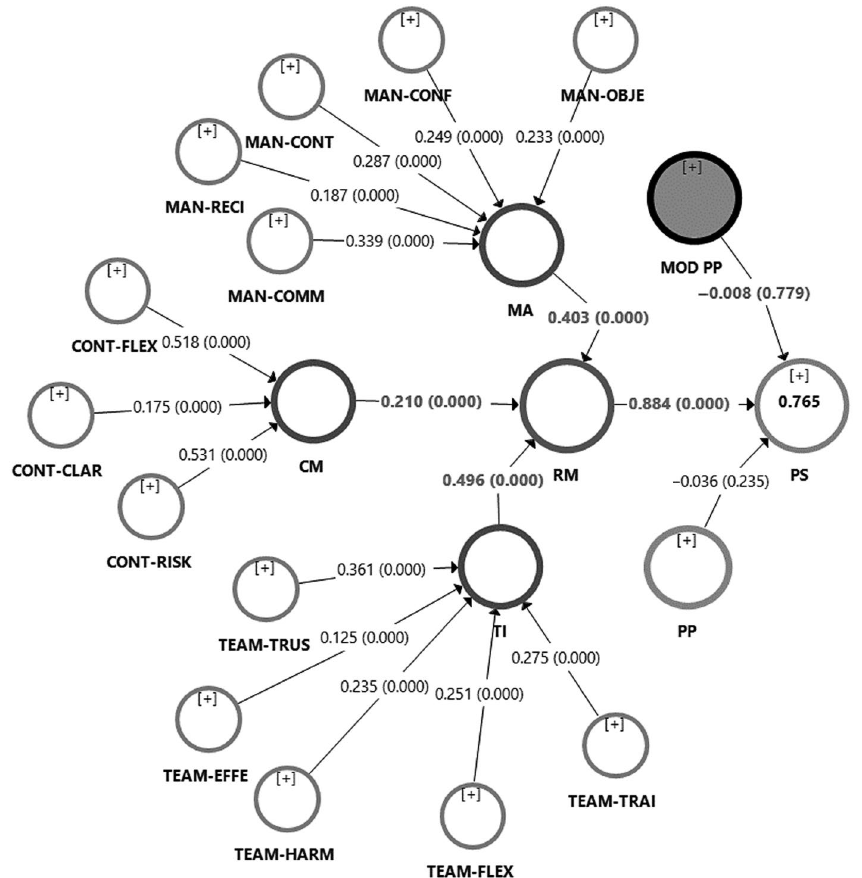
Figure 4. Hypothesis testing results (Path coefficients,